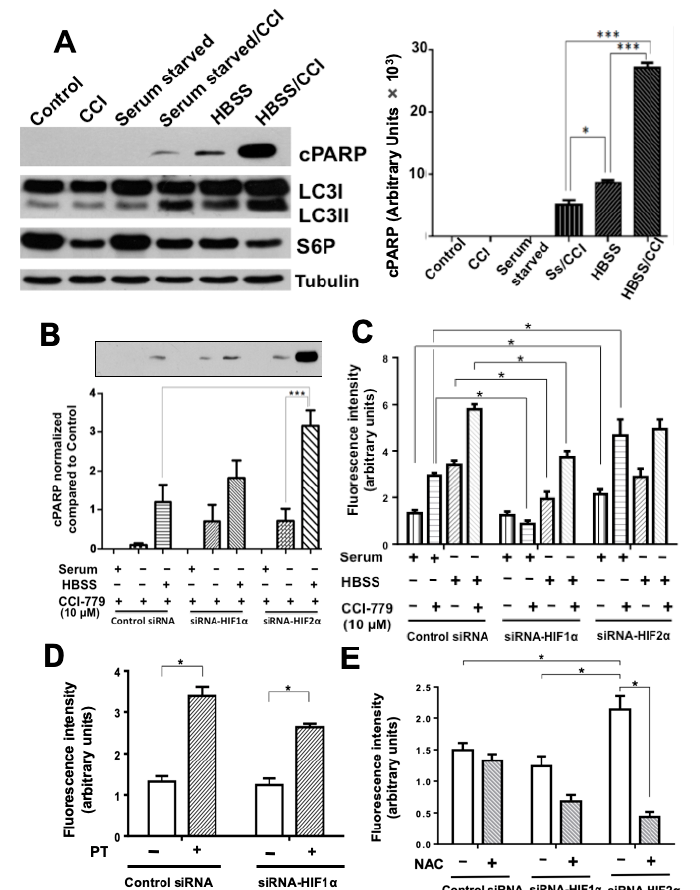
Figure 3. CCI-779-resistant RKO cells are also greatly sensitized to this mTORC1 inhibitor by combining nutritional deprivation with HIF-2 α depletion. ( A ) Cells were grown in the absence or presence of serum (8 h), in the presence of HBSS during 8 h, in the presence of 10 μ M CCI-779, or in combination during 8 h. Cell extracts were analyzed by Western blotting to detect the expression of LC3II/LCI ratio, cleaved PARP, and phosphorylated ribosomal protein S6 (as control of mTOR efficiency inhibition). β -tubulin was used as a control for equal loading. The results shown are representative of three independent experiments. The densitometric analysis shows the changes in LC3II/I ratio and in cleaved PARP levels compared to the levels found in basal (untreated) control HIFs-expressing cells. Bar graphs represent the means ± SEM of at least three independent experiments. * p < 0.05; *** p < 0.001. ( B ) Control or HIFs-silenced cells were grown in the absence or presence of serum, HBSS or 10 μ M CCI-779 alone, or in combination, during 8 h. The presence of apoptosis by cleaved PARP detection was examined in each condition by Western blotting (panel B). Densitometric analysis was performed to estimate the changes in cleaved PARP levels compared to the levels found in controls. The bar graph shows the means ± SEM from at least three independent experiments. *** p < 0.001. ( C–E ) HIF-2 α depletion increases oxidative stress. ( C ) Control or HIFs-silenced cells were grown in the absence or presence of serum, HBSS or 10 μ M CCI-779 alone, or in combination, during 8 h. Oxidative stress was measured by incubating the cells with 5 nM of the oxidation-sensitive fluorescent dye DHE for 20 min at at 37 °C in darkness. Cells were washed, fixed and the fluorescence intensity measured using an inverted confocal fluorescent microscope. The bar graph shows the means ± SEM of fluorescence intensity of 50 cells obtained from at least 8 different view fields for each condition. * p < 0.01. ( D ) Control or HIF-1 α -silenced cells were grown during 16 h in the absence or presence of 100 μ M of the HIF-2 α -specific antagonist PT-2385, and oxidative stress was then measured as described. ( E ) Control or HIFs-silenced cells were incubated in the absence or presence of 3 mM of the antioxidant N -acetylcysteine (NAC) during 2 h. Then oxidative stress was measured as described.